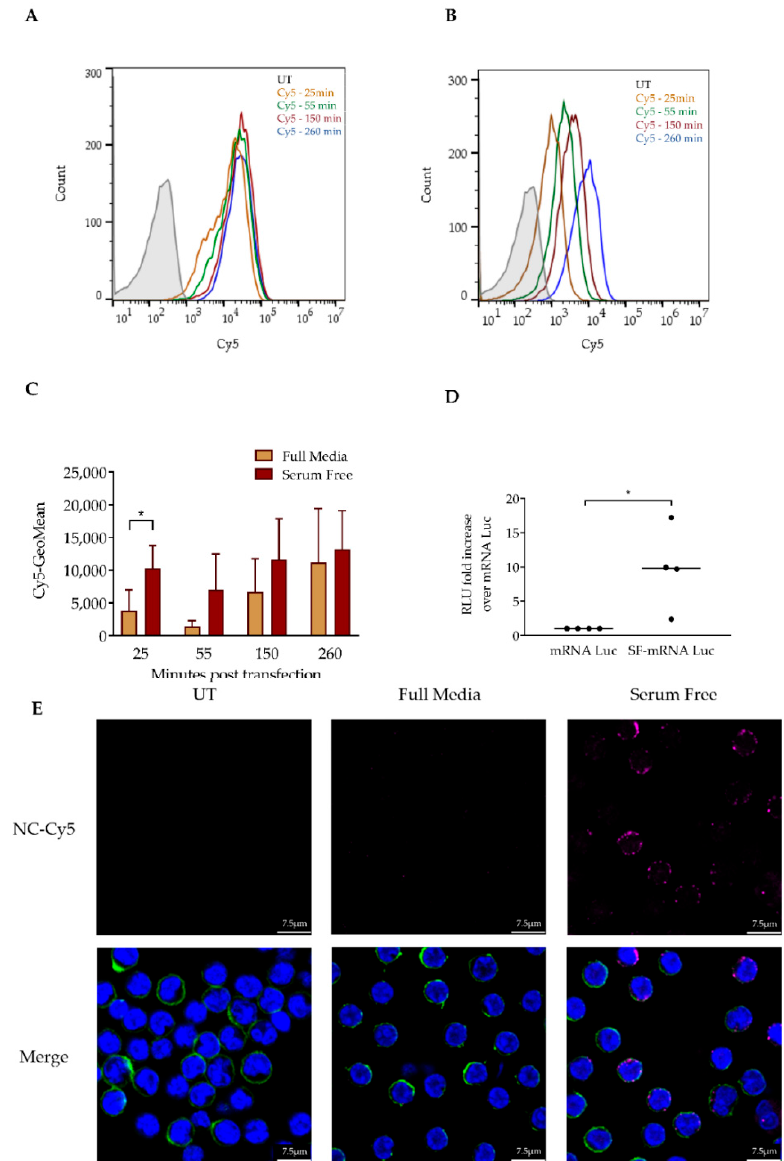
Figure 2. Serum depletion results in rapid LNP uptake into chronic lymphocytic leukemia (CLL) cells. ( A ) CLL patient samples were co-incubated with 4 µ g / mL of NC-Cy5-LNPs in serum-free media (SF). Fluorescence was determined 25, 55, 150 and 260 min post transfection by flow cytometry. ( B ) CLL samples were transfected and co-incubated with 4 µ g / mL of NC-Cy5-LNPs in media containing 10% fetal calf serum (FCS). Fluorescence was determined 25, 55, 150 and 260 min post transfection by flow cytometry. ( C ) Geometric mean of NC-Cy5-LNPs signal determined at sequential timepoints ( n = 3). ( D ) Comparison of fold change in the expression of Luciferase mRNA encapsulated in LNPs (mRNA-Luc). CLL patient samples ( n = 4) were transfected in 10% FCS or serum-free media with 2.5 µ g / mL mRNA-Luc. After 3 h, FCS was replenished to a total of 10% of well volume in serum-free conditions. Luciferase expression was determined 24 h post transfection by a luminometer; measured in relative luminescence units (RLU). ( E ) Images of cells transfected with 4 µ g / mL NC-Cy5-LNPs (red) 25 min post transfection in full or serum-free media. Cells were stained with Hoechst (blue) and CD44 membrane staining (green). Nucleus and membrane staining has been removed from top row images to better visualize LNP uptake. Imaged by confocal microscopy. For all experiments: (*) p < 0.05 (two-sided Student’s t -test).